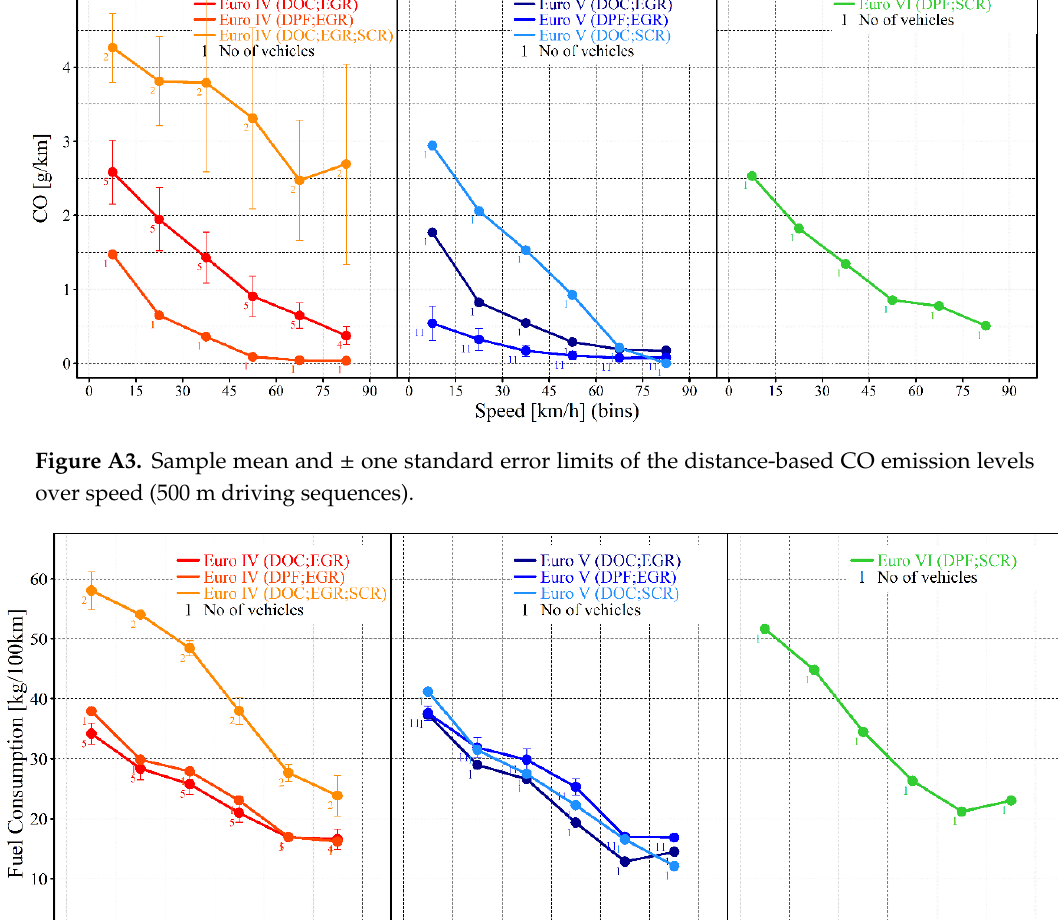
Figure A2. Sample mean and ± one standard error limits of the distance-based THC emission levels over speed (500m driving sequences).